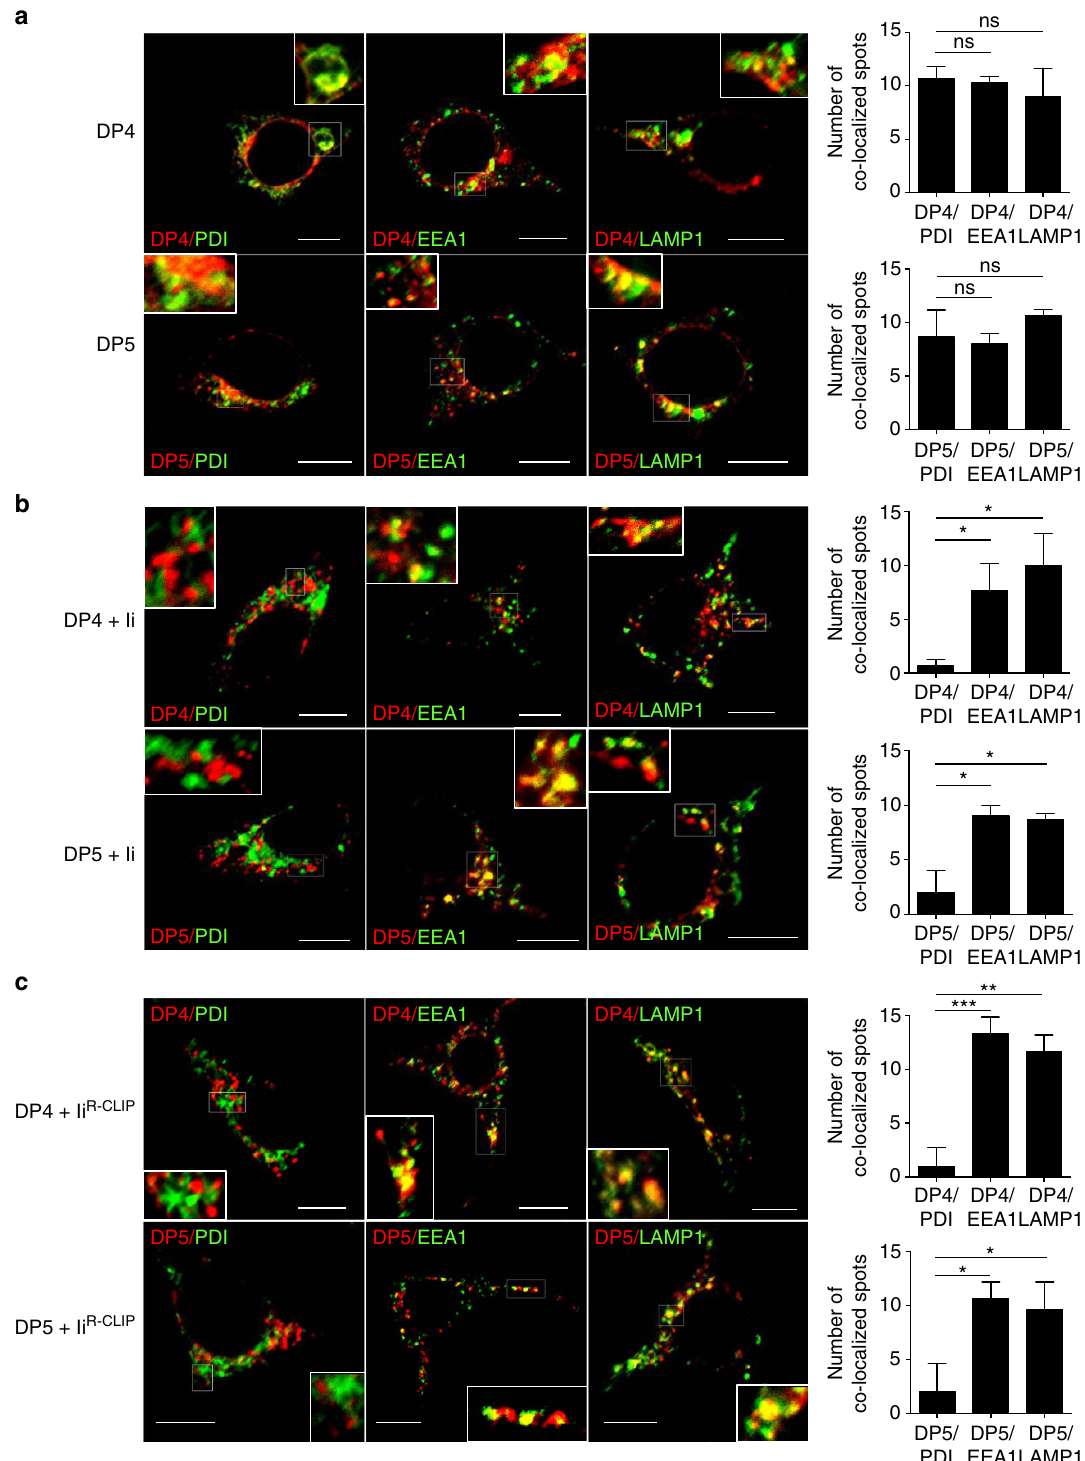
Figure 4 | Subcellular localization of DP4 and DP5 in the presence or absence of Ii. ( a – c ) HEK293 cells were transfected with the indicated combinations of genes. Fixed cells were permeabilized and stained for DP (red) in conjunction with an ER marker, PDI (green, left panels), an early endosomal marker, EEA1 (green, middle panels) or a late endosomal/lysosomal marker, LAMP-1 (green, right panels) and analysed by confocal microscopy. Inset boxes indicate the areas depicted at higher magnification. Scale bar in all images, 10 m m. Quantification of co-localized spots represents means ± s.d. of three counted cells in each condition. ns, not significant; * P o 0.05, ** P o 0.01, *** P o 0.001 by unpaired, two-tailed Welch’s t